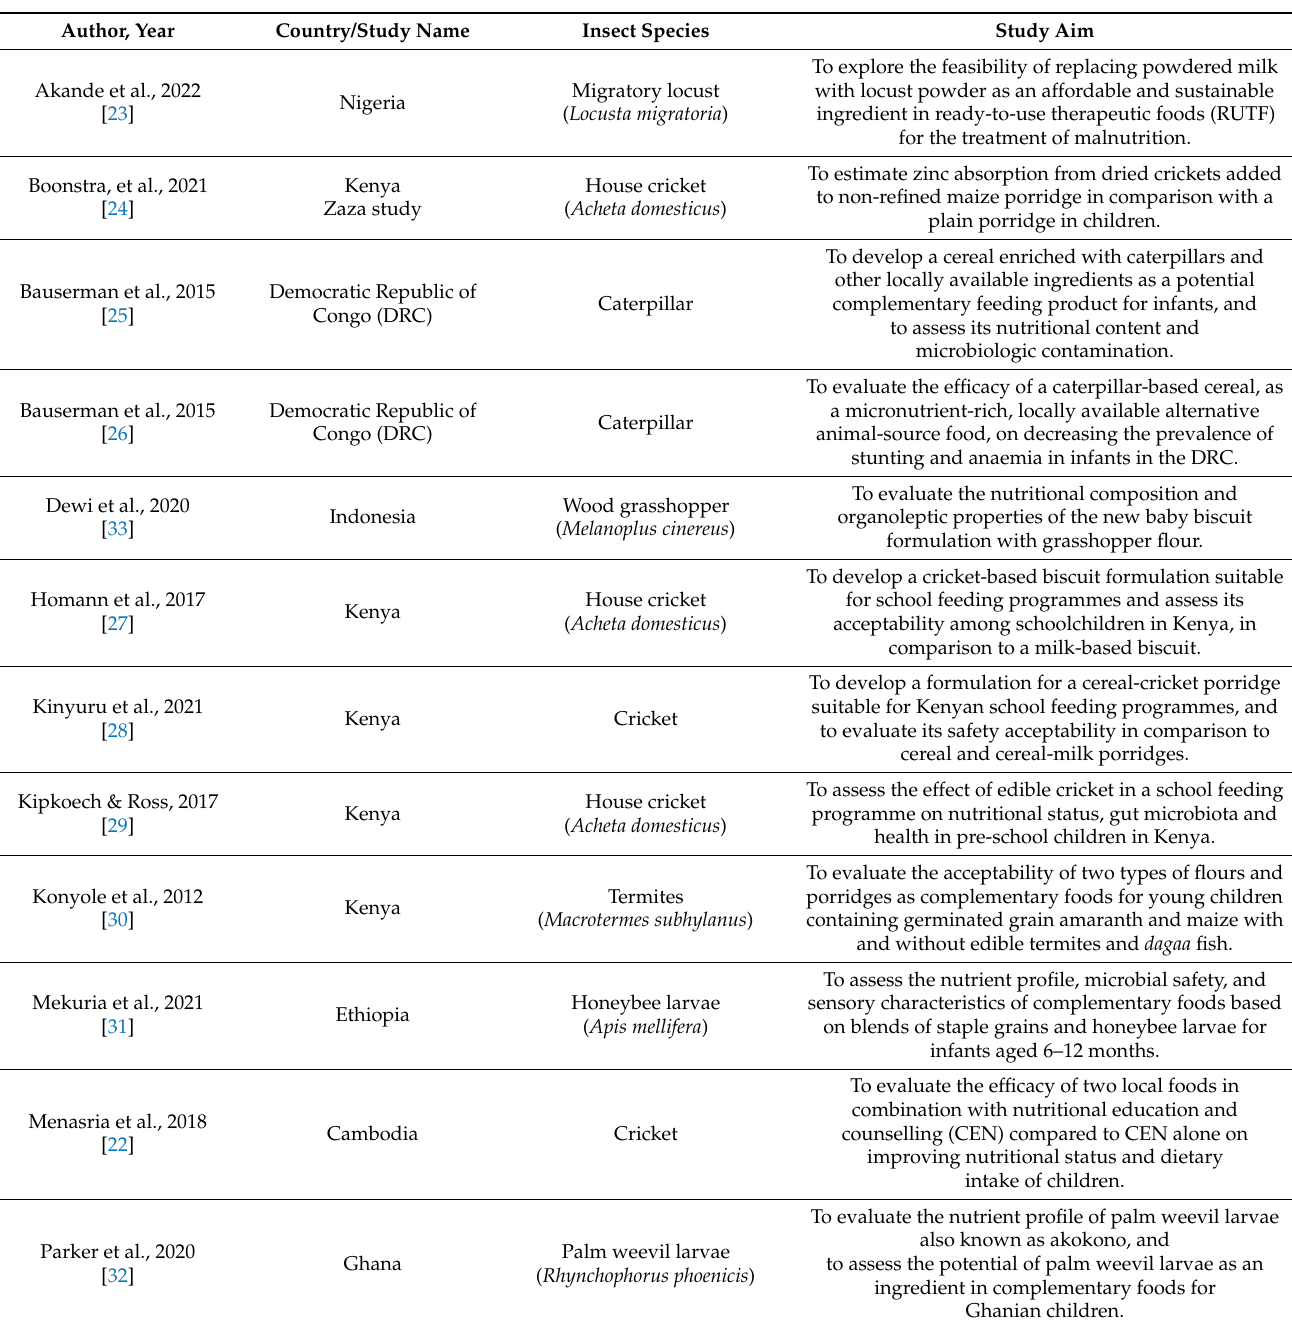
Table 1. General characteristics of all included